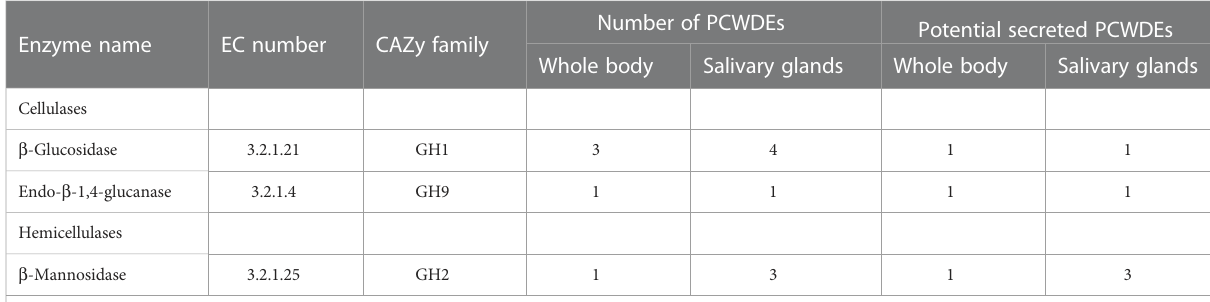
TABLE 1 Plant cell wall-degrading enzymes (PCWDEs) candidates identi fi ed from the whole body and salivary gland transcriptomes of Pseudoregama bambucicola